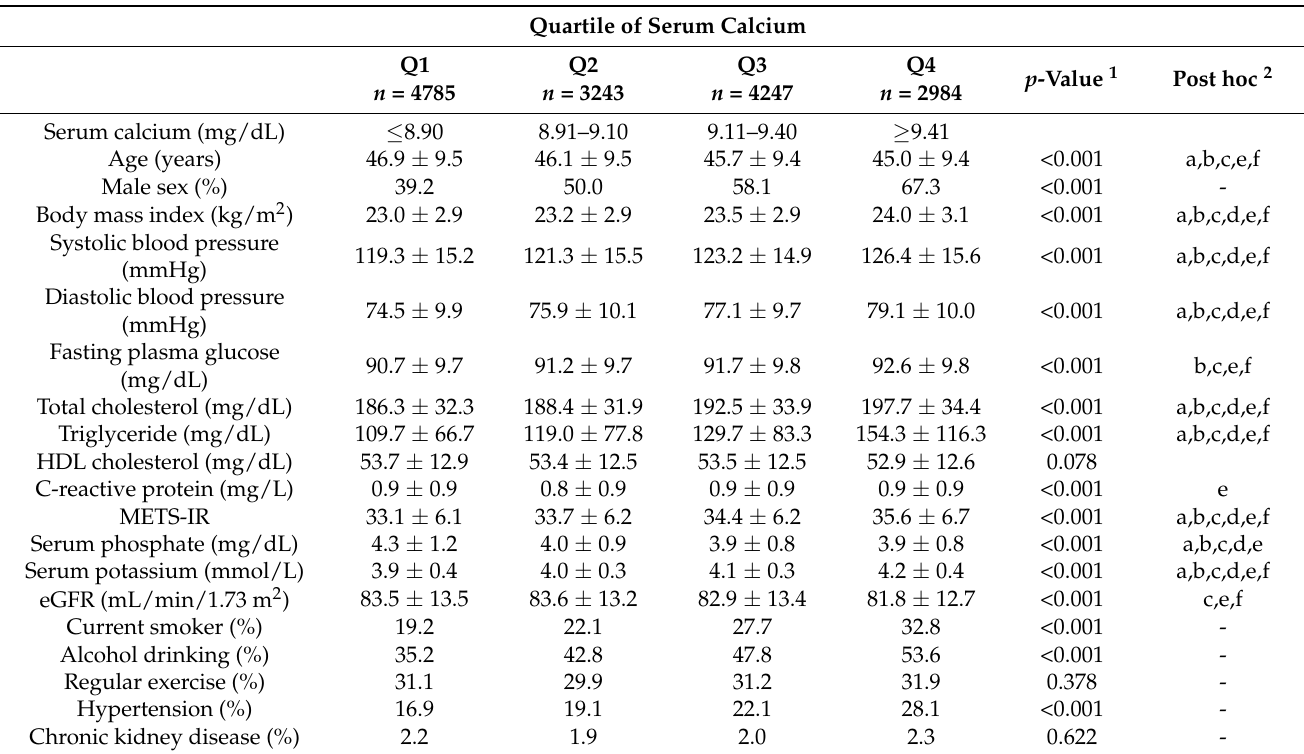
Table 1. Baseline characteristics of the study population according to serum calcium quartiles. Quartile of Serum